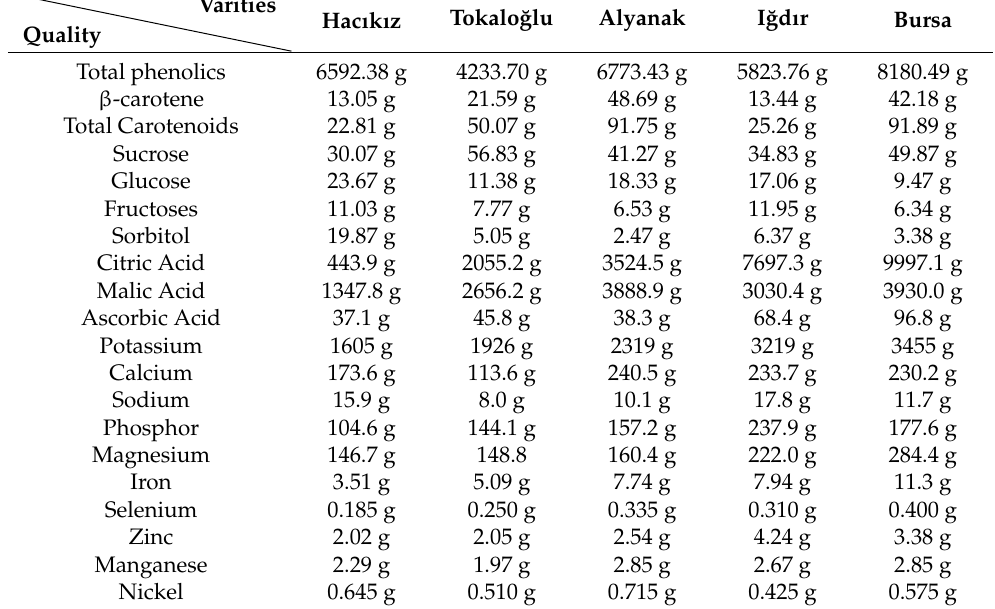
Table 3. The nutritional and chemical composition of some